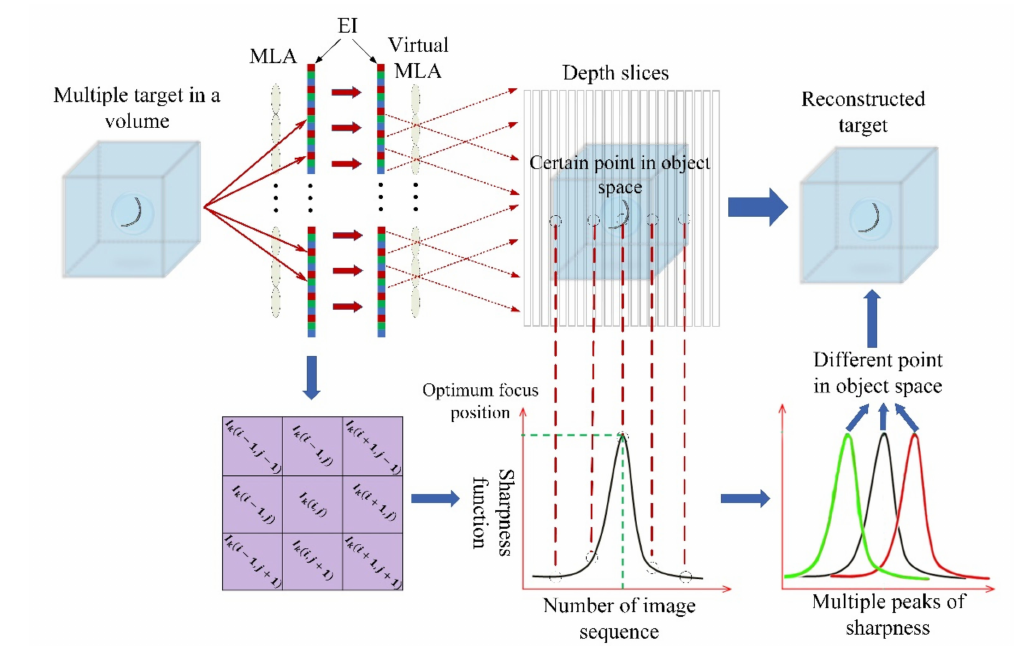
Figure 1. Working principle of reconstruction